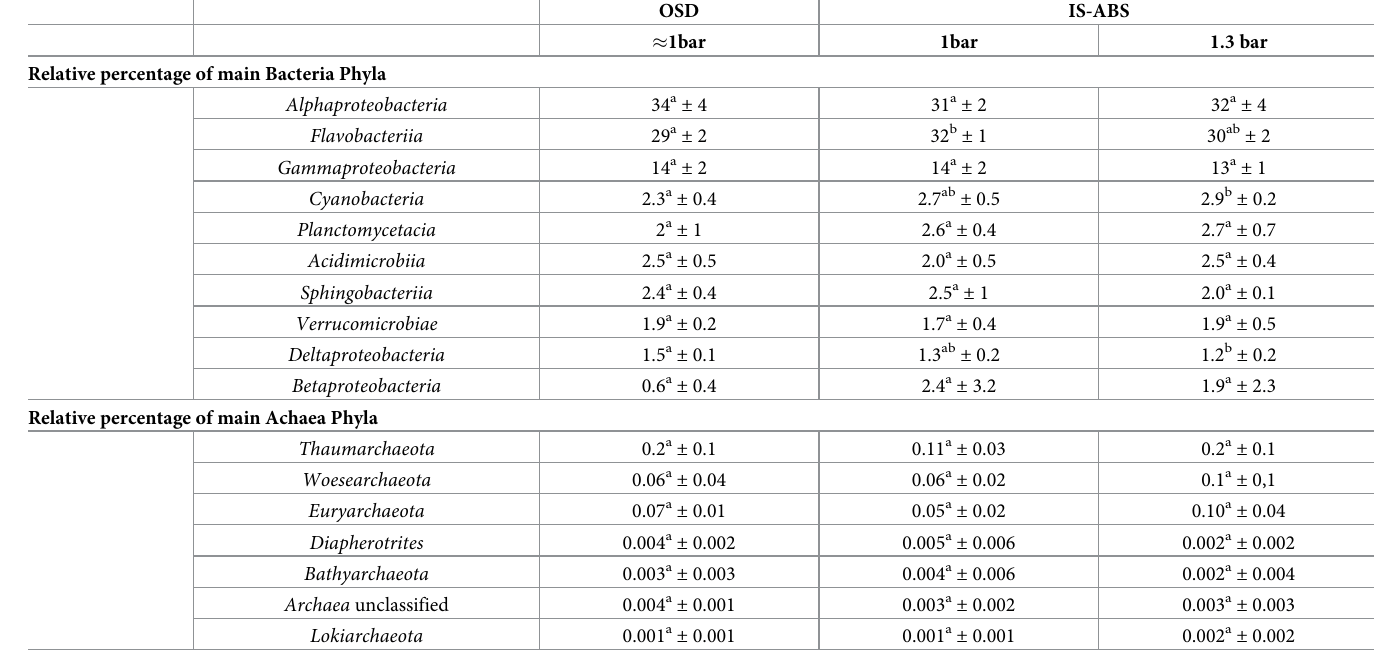
Table 3. Relative percentage ( > 1%) of 16S OTUs (Bacteria and Archaea) taxonomic composition at phylum level. Detected in the tests performed with the Ocean Sampling Day (OSD) standard procedure and with the autonomous biosampler (IS-ABS) (mean ± standard deviation, n = 3). For IS-ABS two filtration pressures were selected (1 and 1.3 bar). Different superscript letters indicate significant (ANOVA, P < 0.05) differences among the three filtration procedures for each phylum.